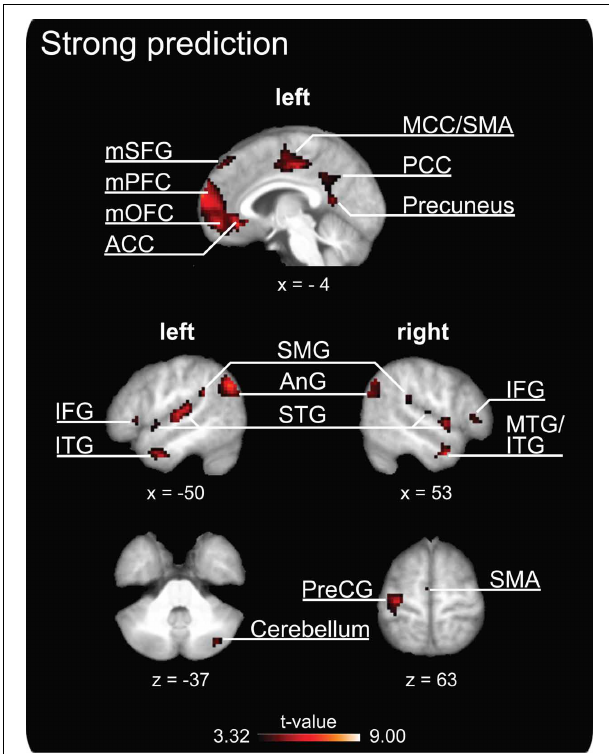
FIGURE 3 | Clusters of increased brain activity that covary positively with the degree of prediction during sensorimotor synchronization. The depicted activations are significant at a threshold of p < 0 . 05, FDR corrected for multiple comparisons. Results are displayed according to neurological convention. The coordinates are given according to MNI space and activations are plotted on the mean anatomy of 18 participants. mSFG, medial superior frontal gyrus; mPFC, medial prefrontal cortex; mOFC, medial orbitofrontal cortex; ACC, anterior cingulate cortex; MCC, middle cingulate cortex; SMA, supplementary motor area; PCC, posterior cingulate cortex; IFG, inferior frontal gyrus; ITG, inferior temporal gyrus; SMG, supramarginal gyrus; AnG, angular gyrus; STG, superior temporal gyrus; MTG, middle temporal gyrus; PreCG, precentral